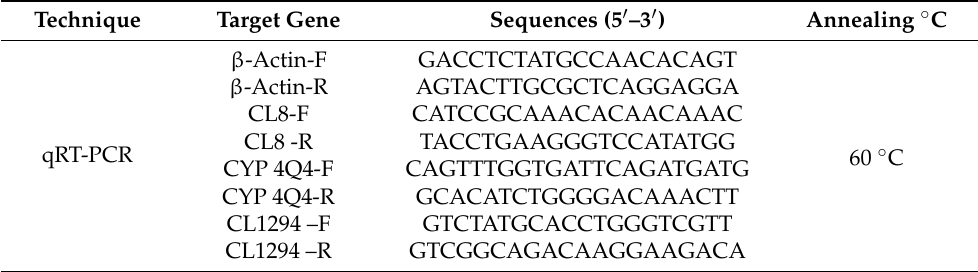
Table 1. Nucleotide primer sequences used in qRT-PCR analysis in S. oryzae adult stage treated with essential oils.